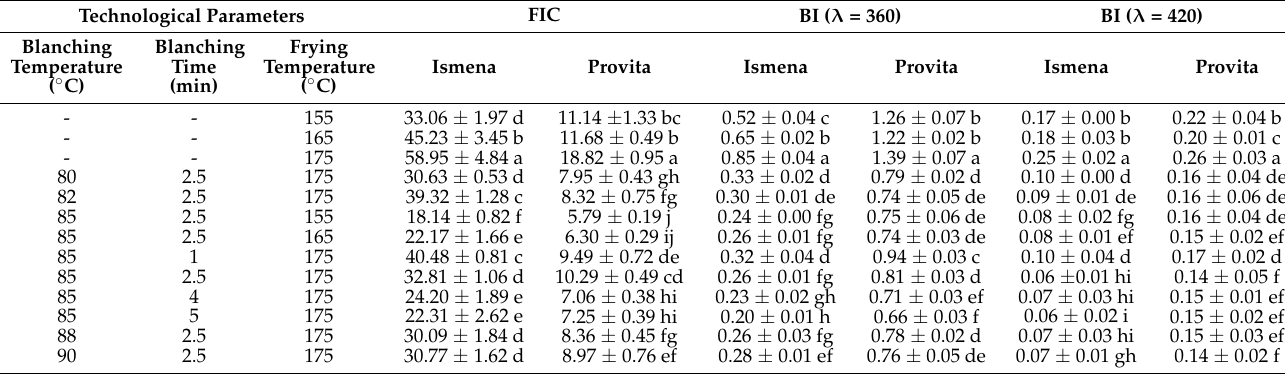
Table 6. FIC and BI in potato crisps, depending on technological